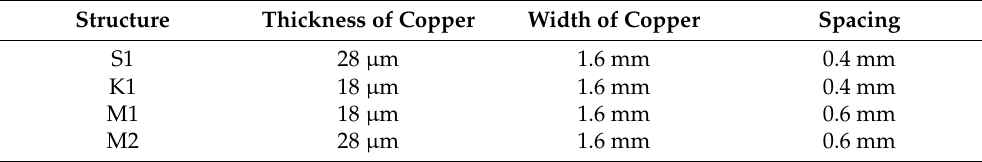
flexible PCBs (top left to bottom right): double spiral structure S1, comb structure K1, double meander structures M1 and M2. Although the two electrical conductors (electrodes) are both made of (identical) copper, they are shown in different colours for reasons of clarity. ( b ) Photo of a rigid PCB with double meander structure M2 (ceramic substrate material). Table 1. The table shows the geometries of the conductor layers of the flexible PCBs (height, width and spacing of copper). Structure Thickness of Copper Width of Copper